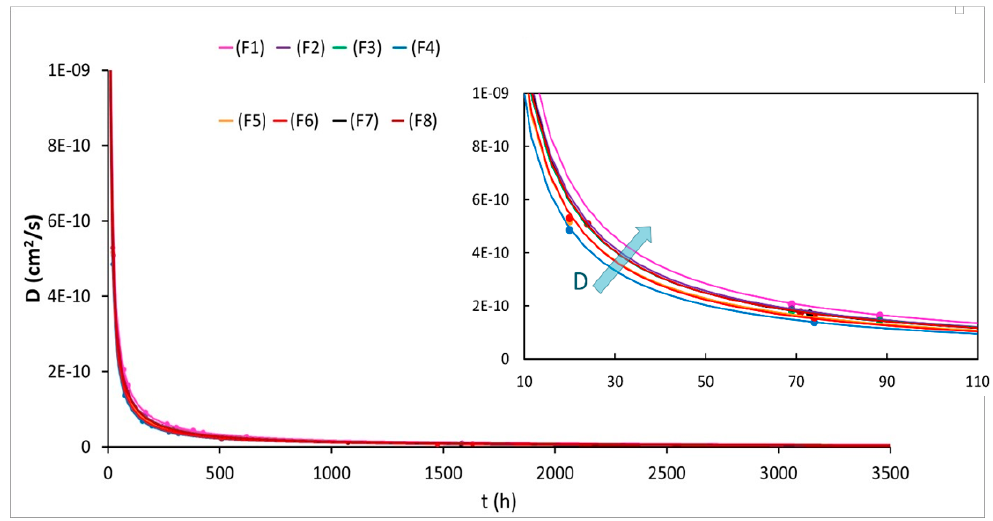
Figure 6. Trend of the diffusion coefficient over the time for all the formulation examined. Table 7. Torque, MVR, and MFR values of the prepared